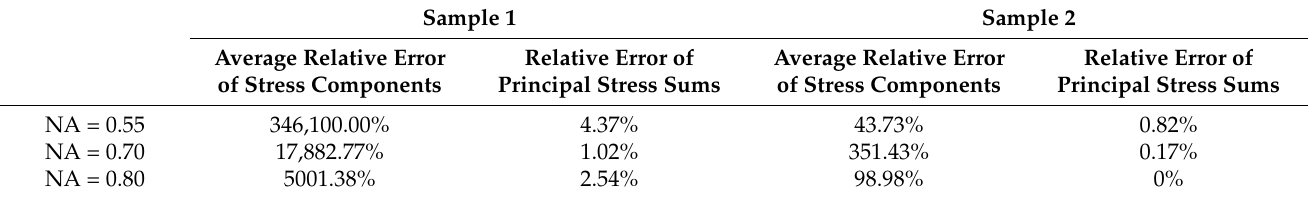
Table 3. Average relative errors of stress components and principal stress sums in physical experi- ments.